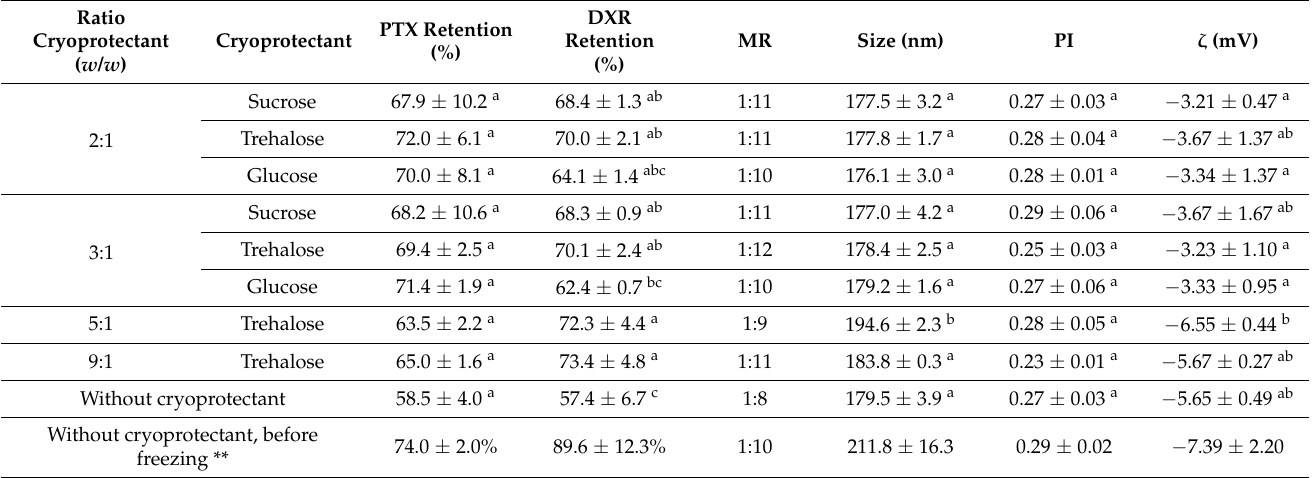
Table 2. Physicochemical characterization of LCFL-PTX/DXR after freeze-thawing using quick cooling rate.